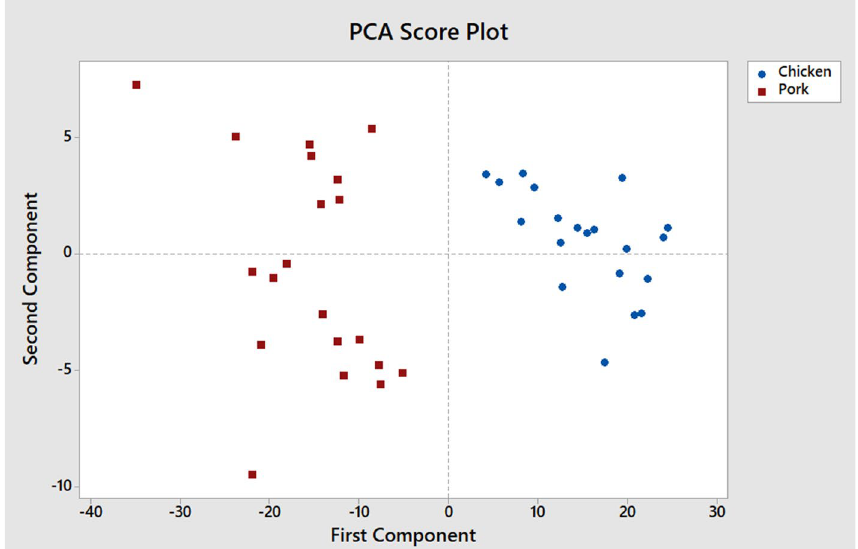
Figure 9. PCA plot of chicken and pork